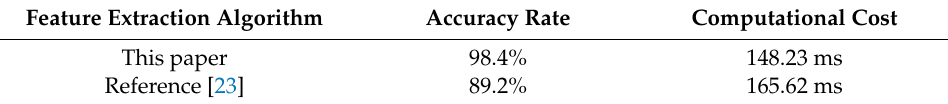
Figure 19. Results of weld joint identification using the reference [23]. Table 3. Recognition results obtained with different feature extraction algorithms.